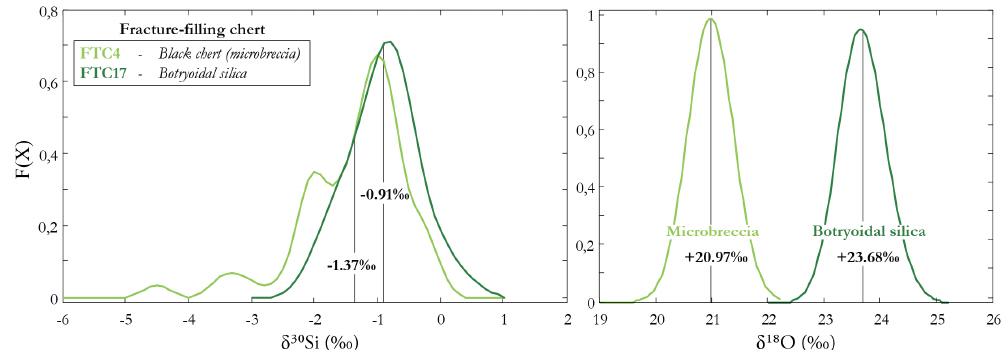
Figure 12. Probability density function showing the distribution of in situ single-grain isotopic composition (oxygen and silicon) within one microbreccia sample (FTC4, light green) and one botryoidal silica sample (FTC17, dark green). Values in black are mean δ 30 Si and δ 18 O. Note the various peaks observed in the negative region for the microbreccia.